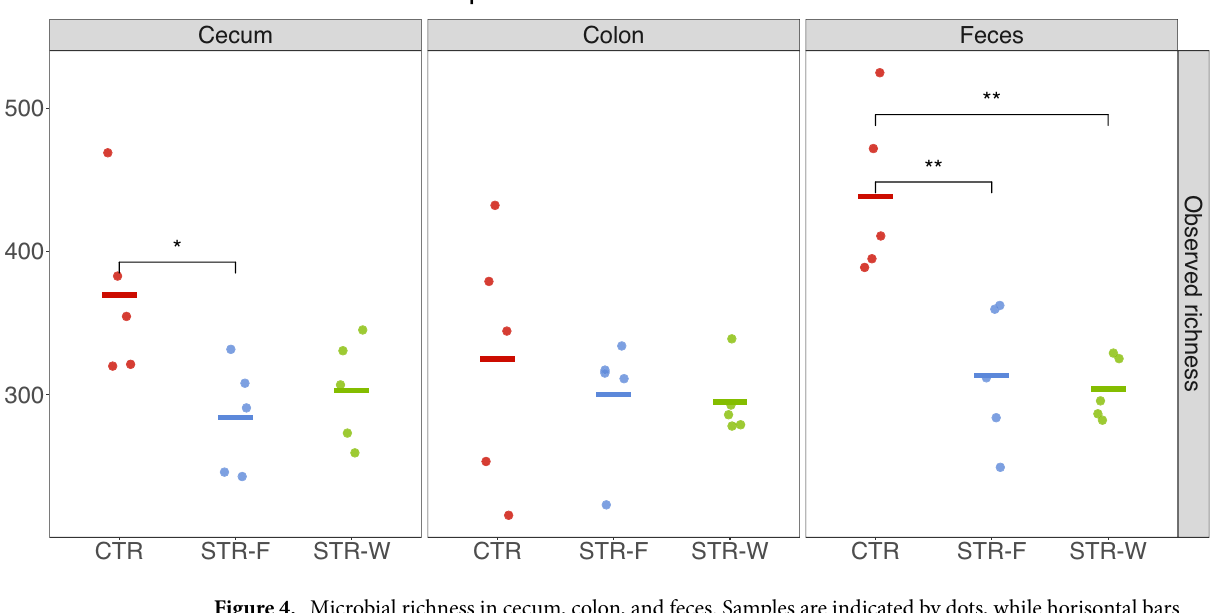
Figure 4. Microbial richness in cecum, colon, and feces. Samples are indicated by dots, while horisontal bars mark the averages. P-values were from the permutational test of the mean and shown as: *( P < 0.05); **( P < 0.01); ***( P <